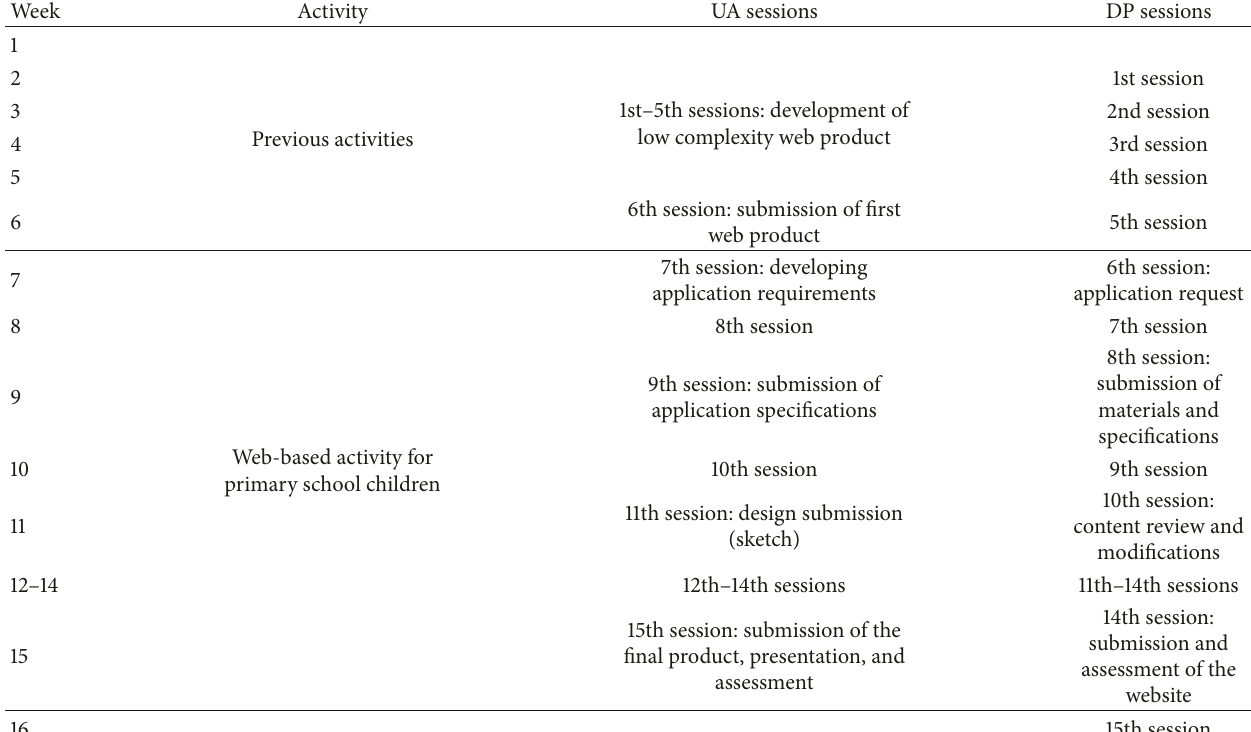
Table 3: Schedule for joint interdisciplinary course